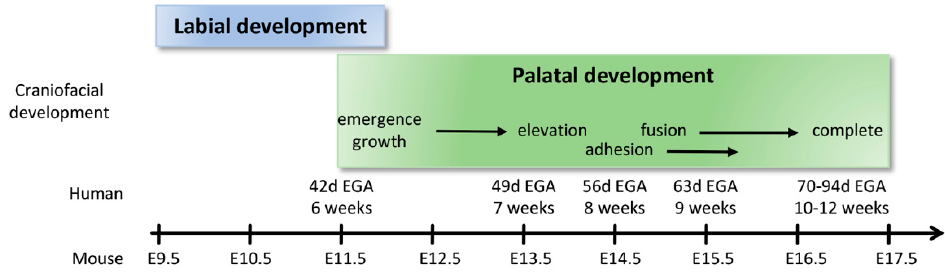
Figure 4. Timeline correlation between human and murine labial and palatal development.